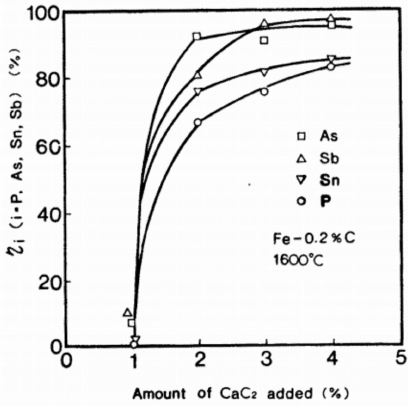
Figure 5. Relationship between residual element removal ratio and CaC 2 addition